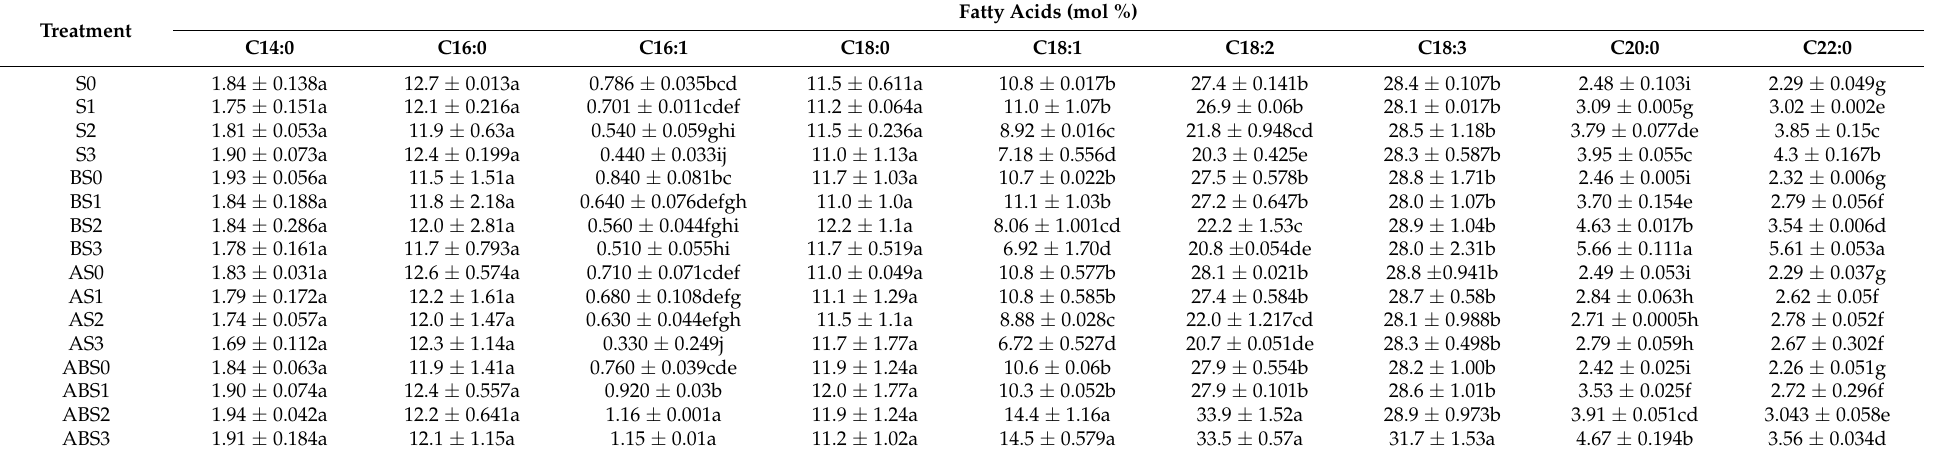
Table 1. Fatty acid composition in lipids of the maize